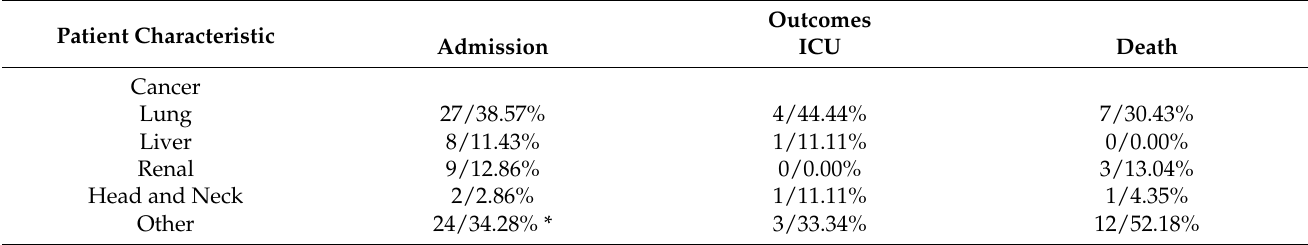
Table 5. Risk factors of admission, ICU and mortality, COVID-19 infection ( n =